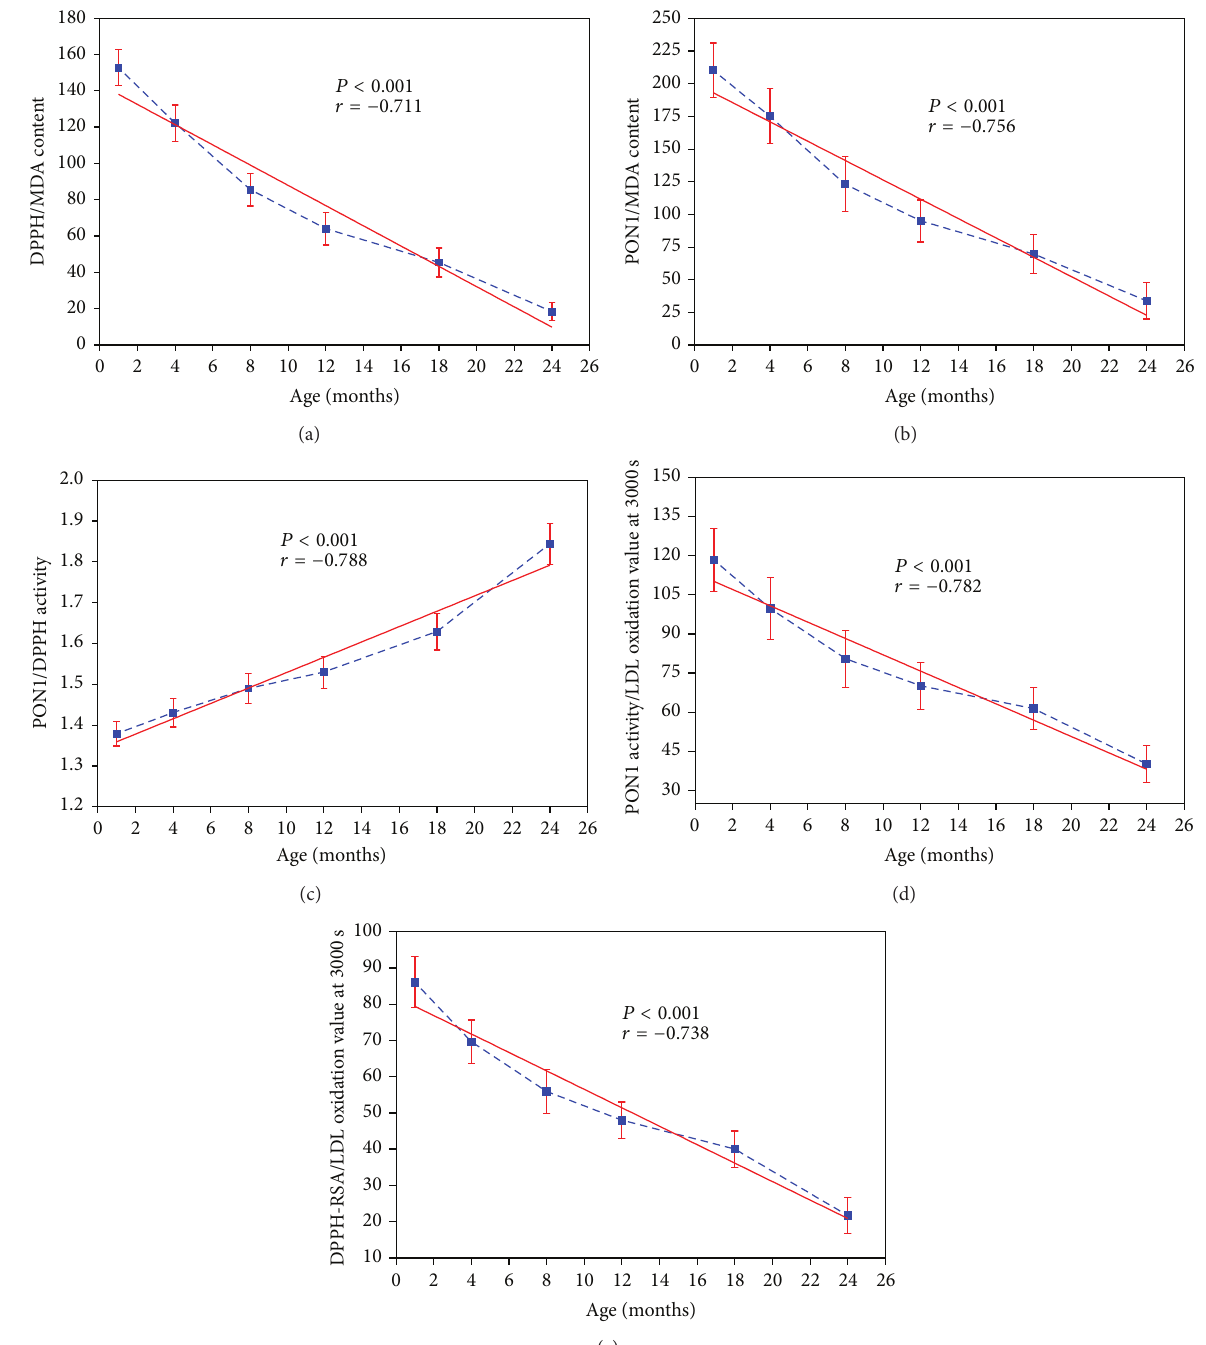
Figure 5: (a) Correlation of quotient of DPPH-RSA and plasma MDA level as a function of rat age. (b) Correlation of quotient of PON1 arylesterase activity and MDA level as a function of rat age. (c) Correlation of quotient of PON1 arylesterase activity with plasma DPPH- radical scavenging activity as a function of rat age. (d) Correlation of quotient of PON1 arylesterase activity and LDL oxidation level at 3000 sec plotted as a function of rat age. (e) Correlation of quotient of DPPH-RSA and LDL oxidation level at 3000 sec plotted as a function of rat